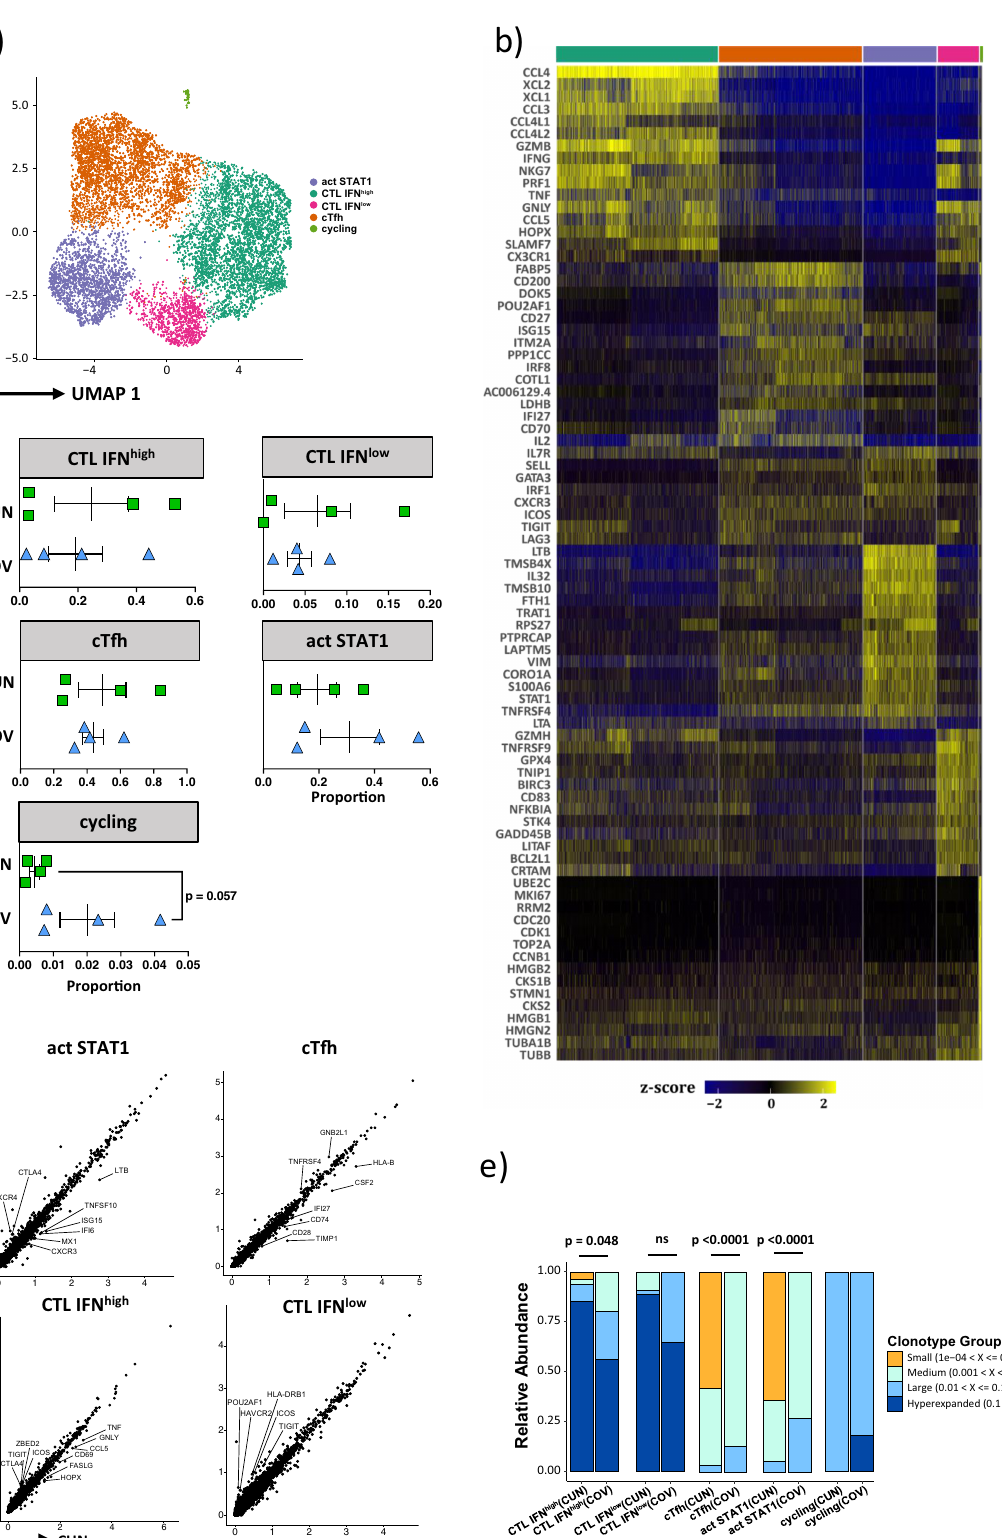
PD-1 on the cell surface, likely suggesting that in these patients a compensatory mechanism could exist that attempts to mount a better immune response. Aged patients were characterized by higher percentage of CD57 + NK cells, a particular population of highly cytotoxic elements at the fi nal stage of their maturation. This